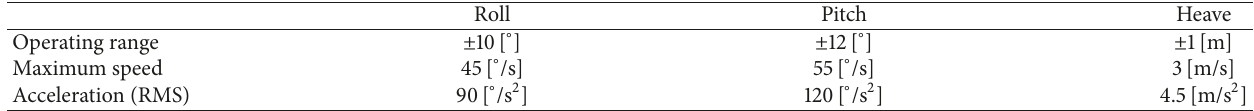
Table 2: Design specifications for the stabilization